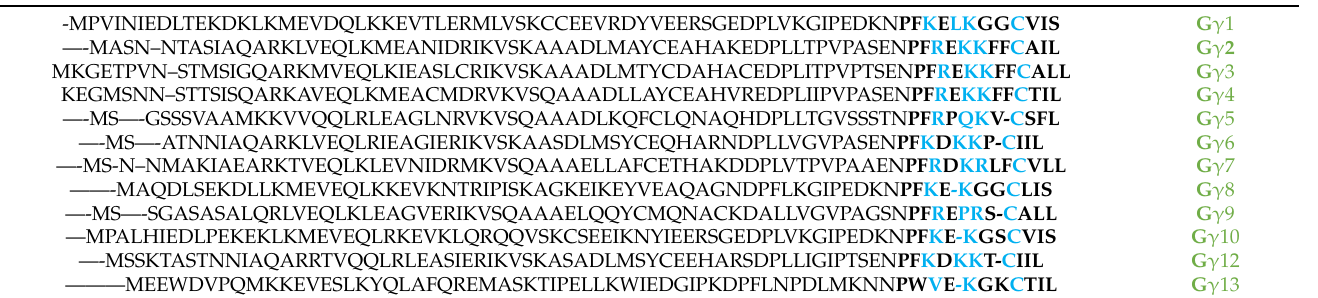
Table 3. Multiple sequence alignment of human G γ